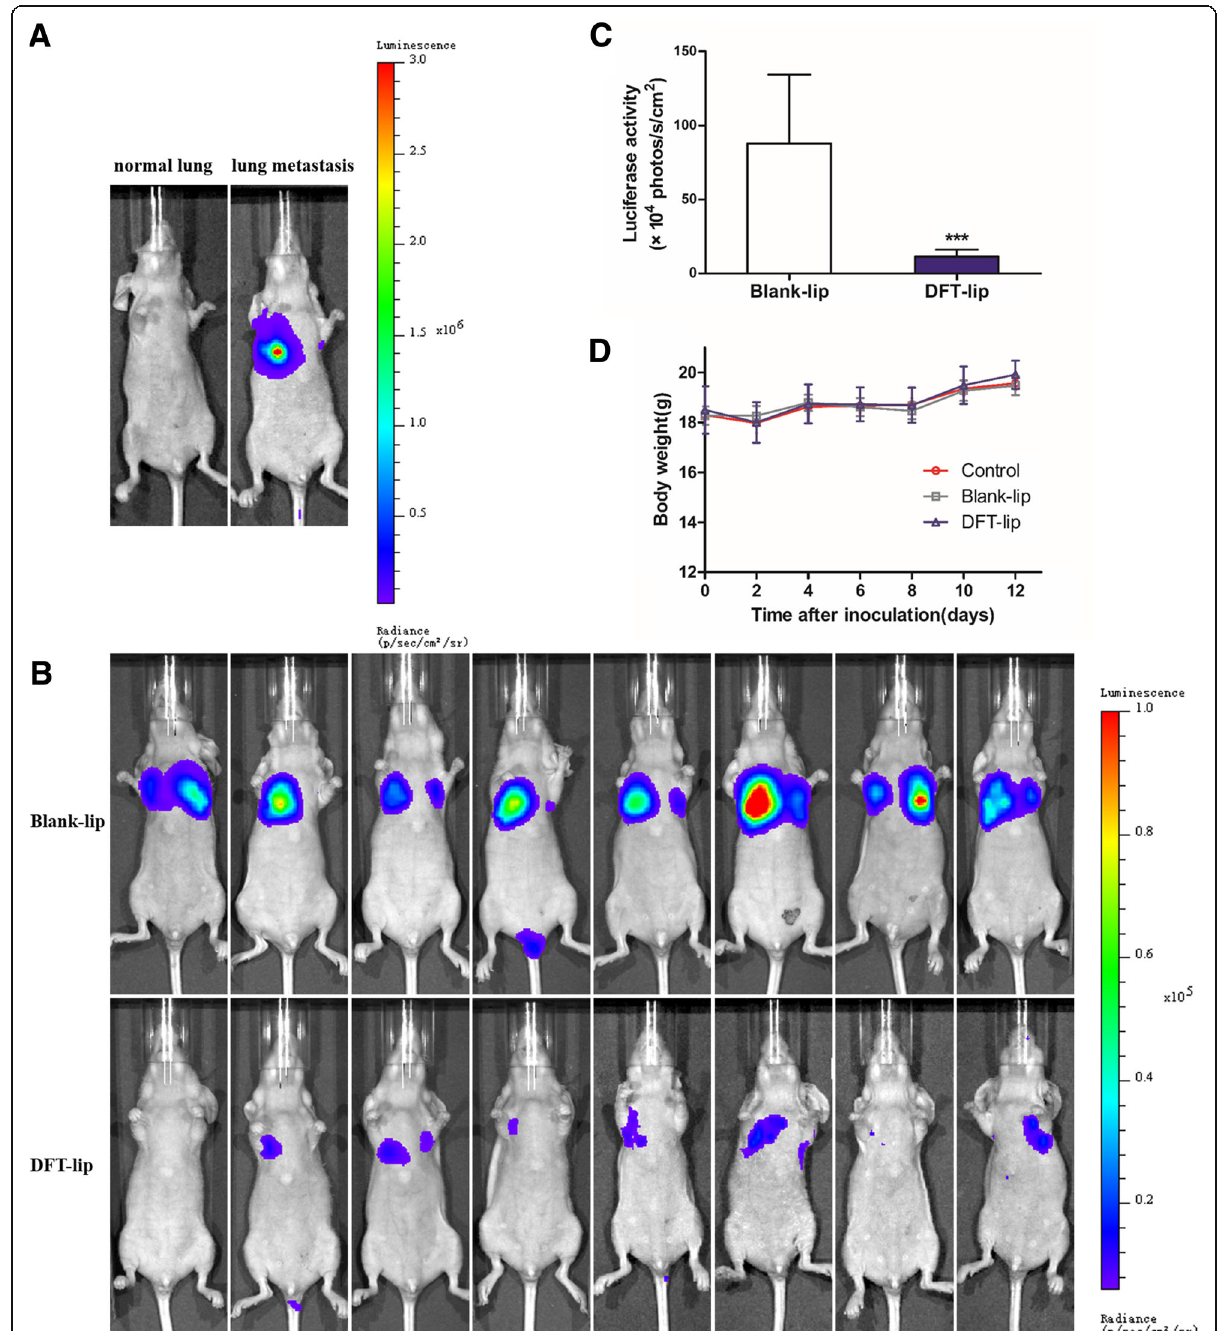
Fig. 7 In vivo anti-metastasis study of the liposomes. a Bioluminescent images of the nude mice model of lung metastasis of breast cancer, which was constructed with the injection of MDA-MB-231/Luc cells via tail vein. b Representative in vivo bioluminescent images of mice in a preventive protocol treated with Blank-lip and DFT-lip ( n = 8). c The extent of tumor metastasis burden was quantified ( n = 8). Notes: *** p < 0.001 versus Blank-Lip. d Body weight changes for the tumor-bearing